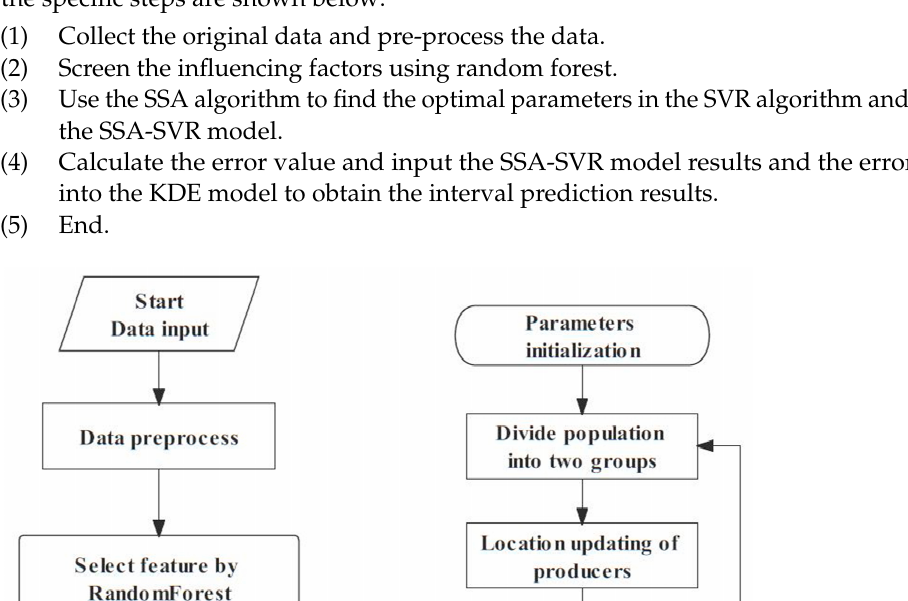
Figure 1. RF-SSA-SVR-KDE model. 3. Results 3.1. Data Preprocessing To eliminate the effect of order-of-magnitude mismatch, the input and output data need to be normalized before model training. We choose to use standard normalization for data preprocessing.